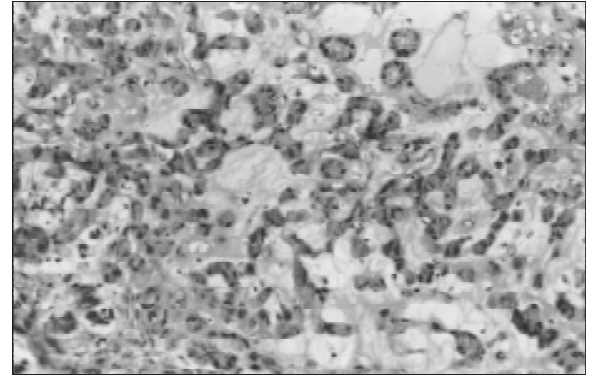
Figura 3 – Cordões constituídos por células cúbicas (H&E 200x)